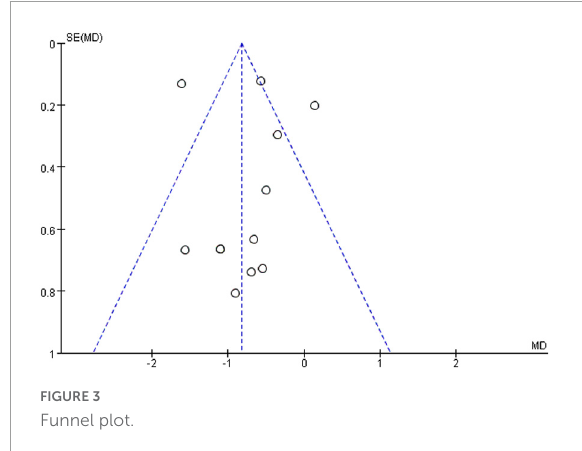
FIGURE3 Funnel plot.